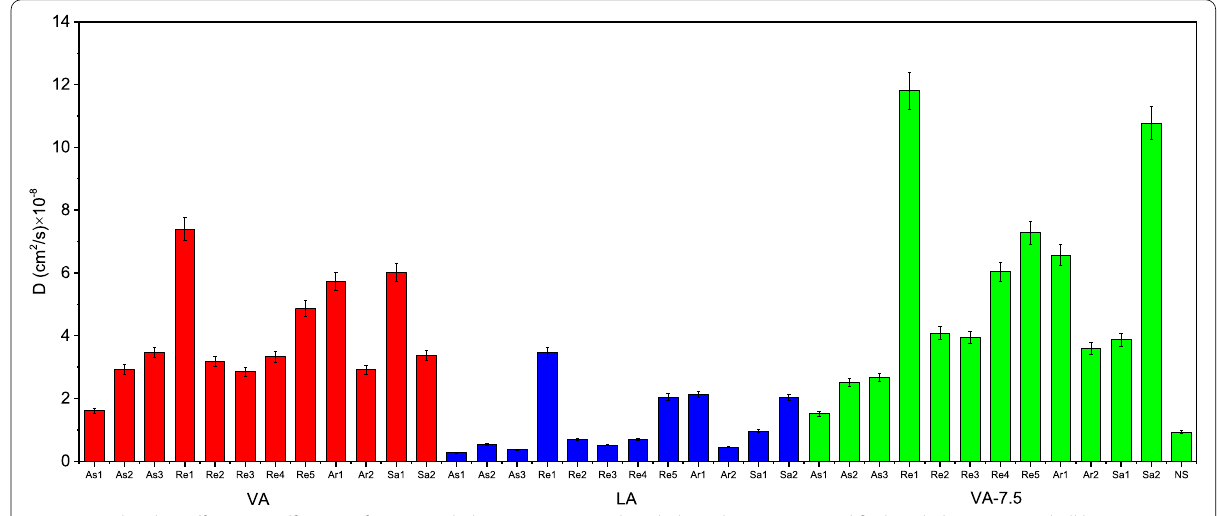
Fig. 19 Molecular Diffusion Coefficients of Virgin Asphalt, Long-Term Aged Asphalt, and nano-SiO 2 Modified Asphalt at 333 K. It shall be noted that As1 is for asphaltene-phenol, As2 is for asphaltene-pyrrole, As3 is for asphaltene-thiophene, Re1 is for benzobisbenzothiophene, Re2 is for pyridinohopane, Re3 is for quinolinohopane, Re4 is for thioisorenieratane, Re5 is for trimethylbenzeneoxane, Ar1 is for dioctyl-cyclohexane-naphthalene (DOCHN), Ar2 is for perhydrophenanthrene-naphthalene (PHPN), Sa1 is for hopane, and Sa2 is for squalane